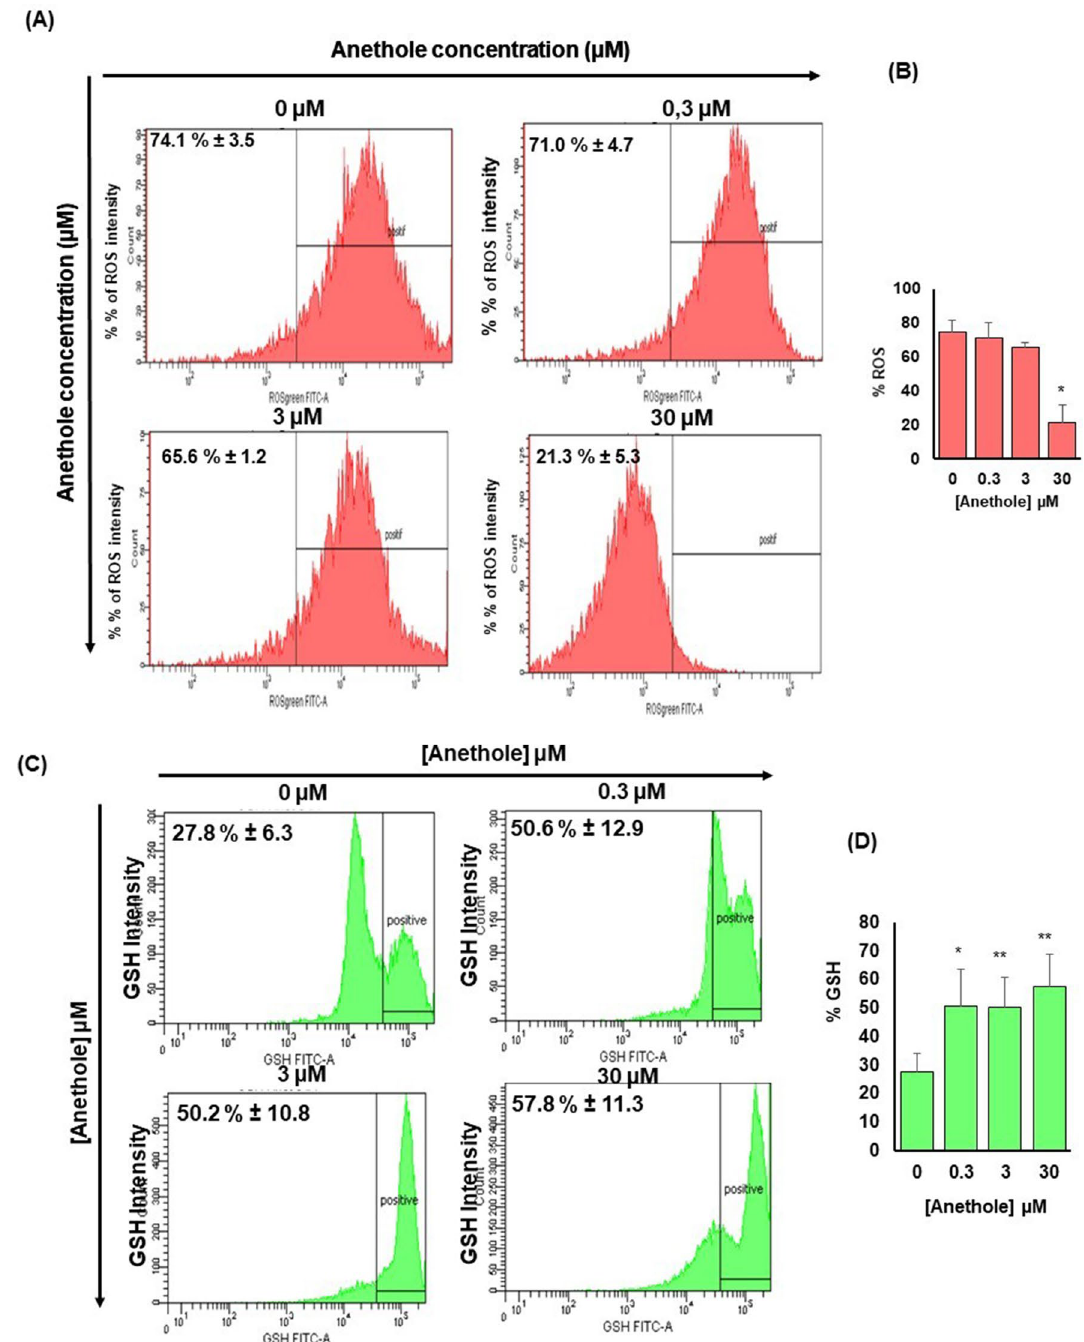
Figure 5. Anethole promotes the inhibition of oxidative stress in oral cancer cells. ( A ) The quantification of ROS by flow cytometry (n = 4) showed an inhibition of approximately 52% when the Ca9-22 cells were treated with anethole (30 μM) for 24 h. ( B ) D) Histogram showing fold changes of ROS between untreated cells and cells treated by anethole concentration. ( C ) The flow cytometry analysis of the intracellular GSH (n = 4) revealed an increase of approximately 29% after 24 h of stimulation with anethole. ( D ) Histogram showing fold changes of GSH expression. Results have been reported with means (%) ± SD. Significance was obtained when comparing the control to anethole treated cells, * p <